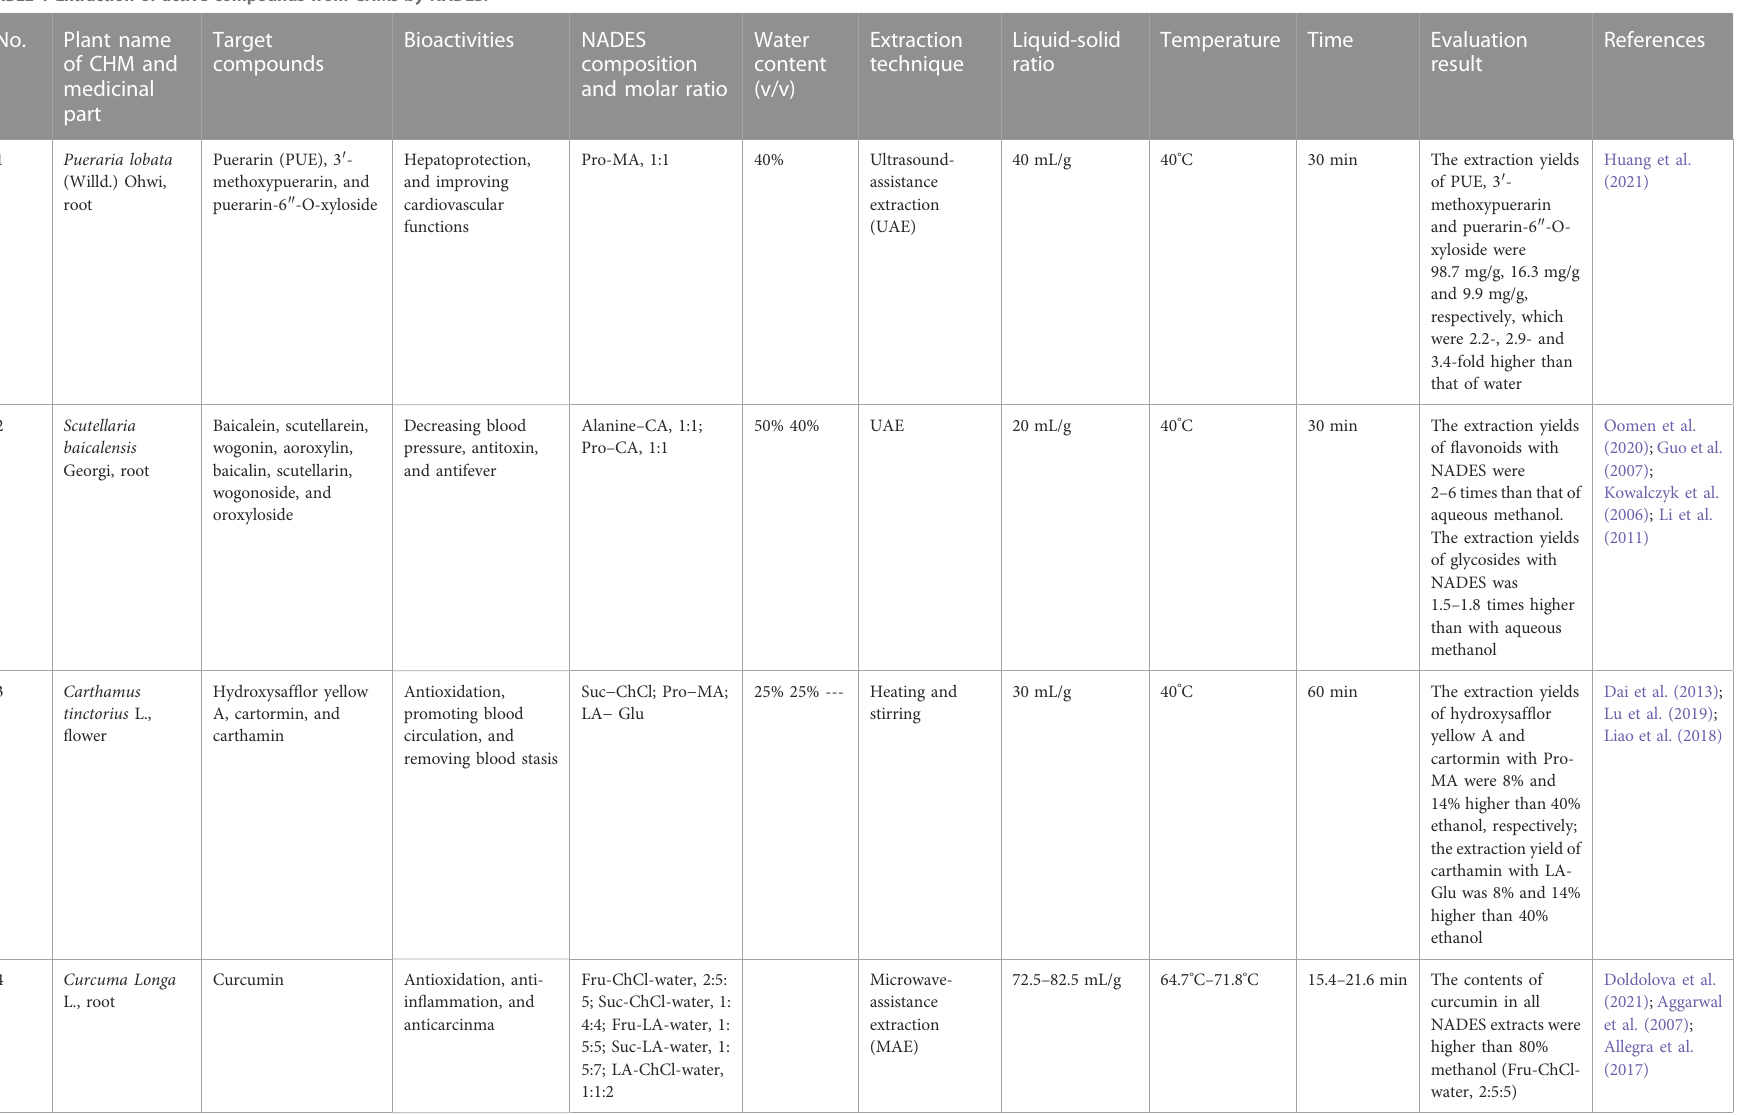
TABLE 1 Extraction of active compounds from CHMs by